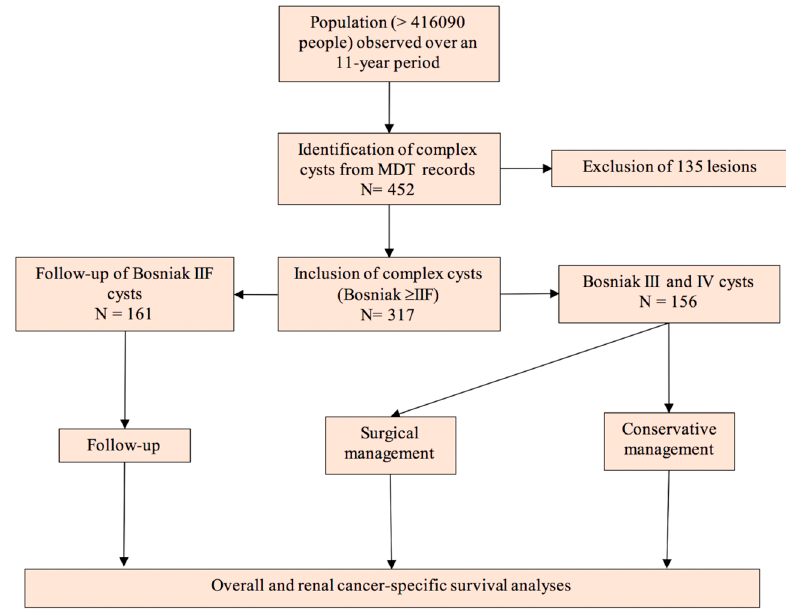
Figure 5. Study design.